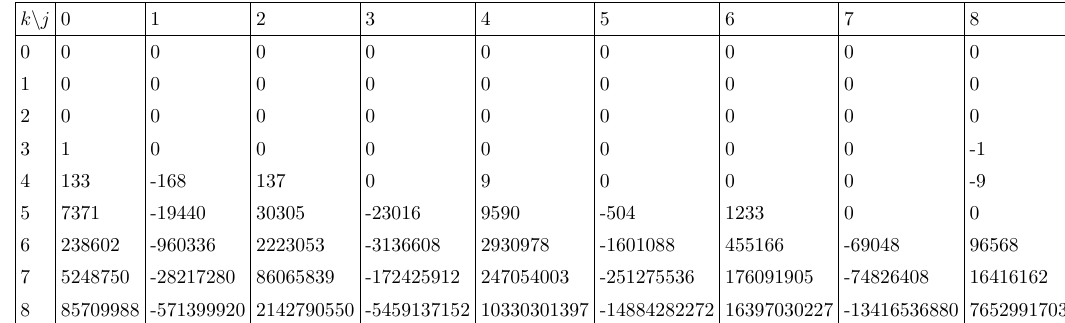
Table 85. Table of b jk coe(cid:14)cients for h E 7